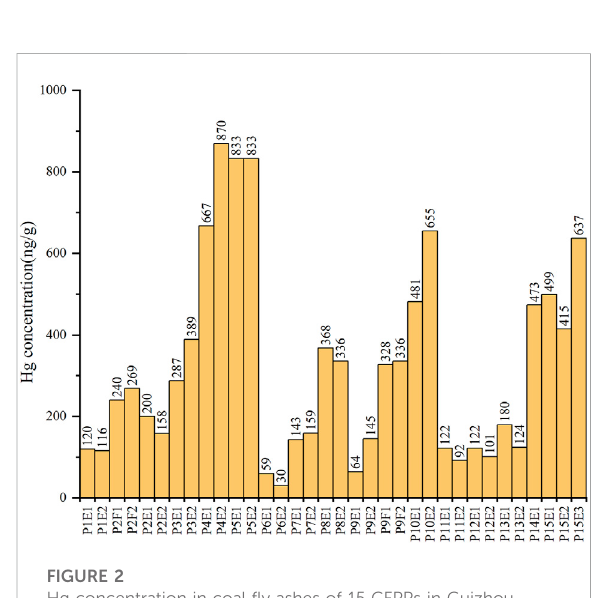
FIGURE 2 Hg concentration in coal fl y ashes of 15 CFPPs in Guizhou